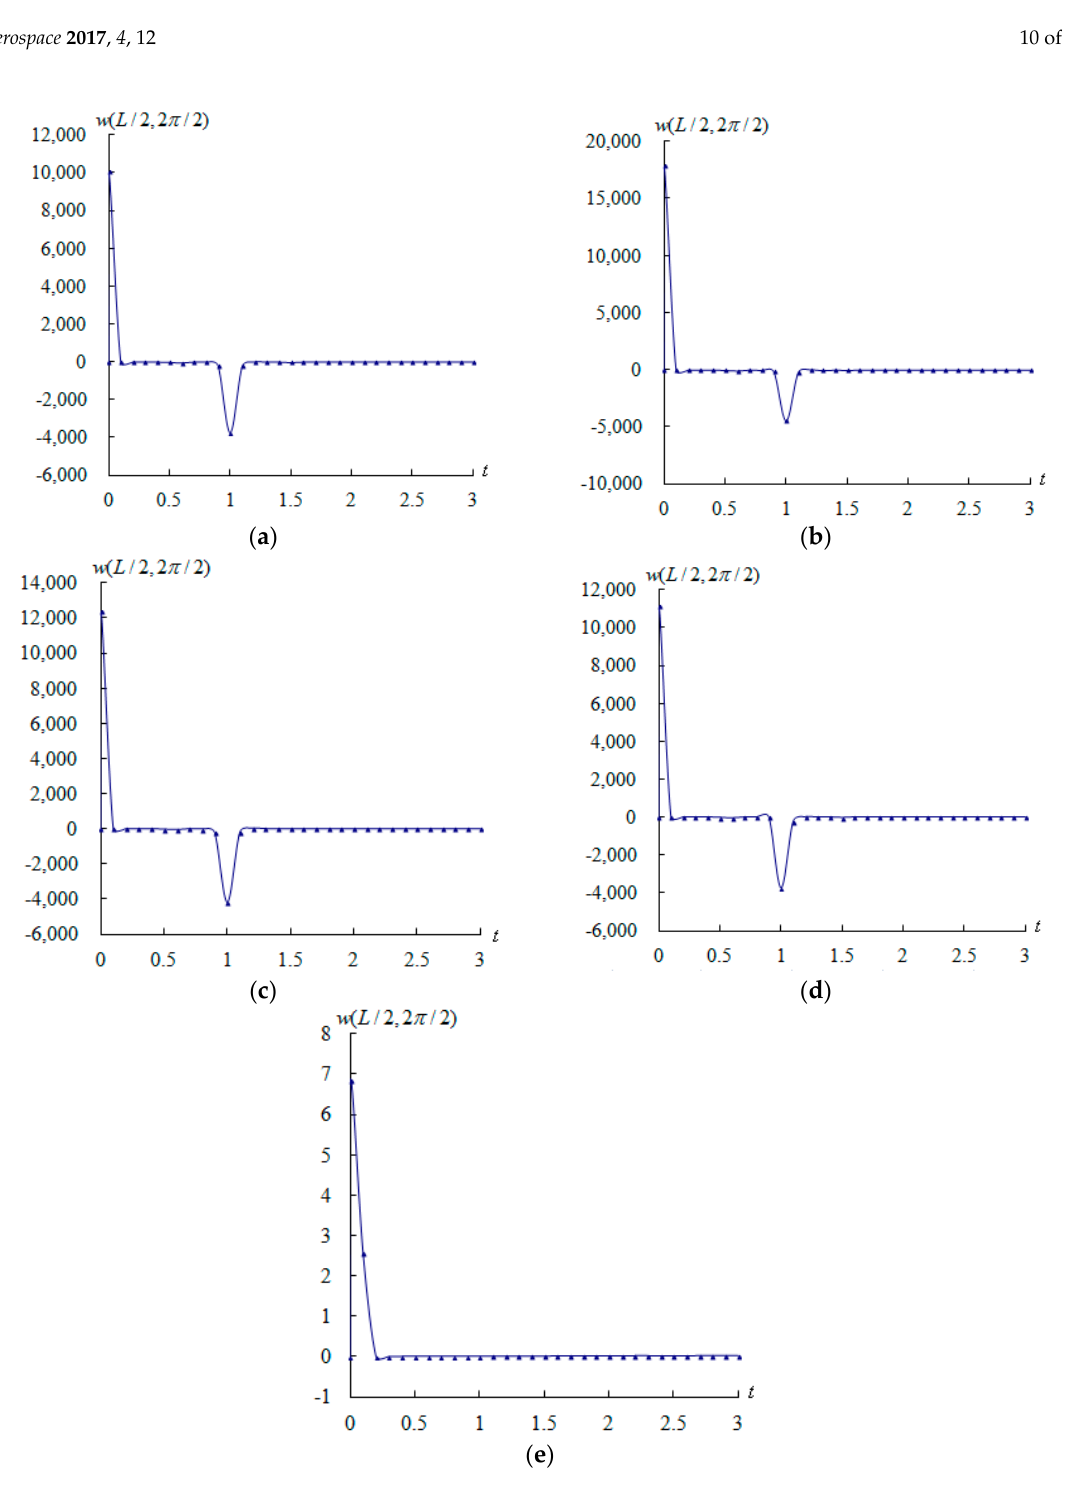
π Lw π Lw Figure 4. )2/2,2/( (mm) versus t (s) for 2 = ∞ M , 4 and 10: ( a ) )2/2,2/( Figure 4. w ( L /2,2 π /2 ) (mm) versus t (s) for M ∞ = 2, 4 and 10: ( a ) w ( L /2,2 π /2 ) (mm) versus t (s) π Lw (mm) versus t (s) for 4 = ∞ M ; ( c ) (mm) versus t (s) for 2 = ∞ M ; ( b ) )2/2,2/( for M ∞ = 2; ( b ) w ( L /2,2 π /2 ) (mm) versus t (s) for M ∞ = 4; ( c ) w ( L /2,2 π /2 ) (mm) versus t (s) for )2/2,2/( π Lw (mm) versus t (s) for 10 = M ; ( d ) for 2 = M in steady flow; and ( e ) M ∞ = 10; ( d ) for M ∞ = 2 in steady flow; and ( e ) without air ∞ ∞ without air flow.